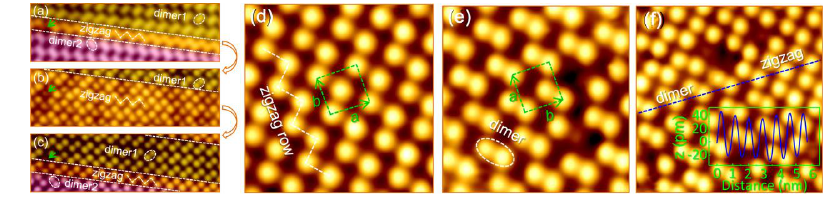
Figure 8. STM images of MAPbI 3 crystal films deposited on an Au(111) crystal surface. ( a – c ) Sequential images acquired at the same region showing the reversible transition between the dimer and zigzag structures (4.2 × 12.8 nm 2 ; U = 2.0, 0.85, and −1.25 V; I = 30 pA). Phase boundaries are denoted by dotted lines. Iodine zigzag rows and dimers are denoted by dashed lines and ellipses, respectively; ( d , e ) Zoom-in view of the zigzag and dimer structures (4.3 × 4.3 nm 2 ; 2.5 V; 50 pA). The unit cell is denoted by dashed rectangles; ( f ) STM image of the two phases coexisting at the same region (5.6 × 5.6 nm 2 ; U = 2.5 V; I = 50 pA). The inset is the height profile along the dashed line. The figure was taken from Reference [52] with permission.